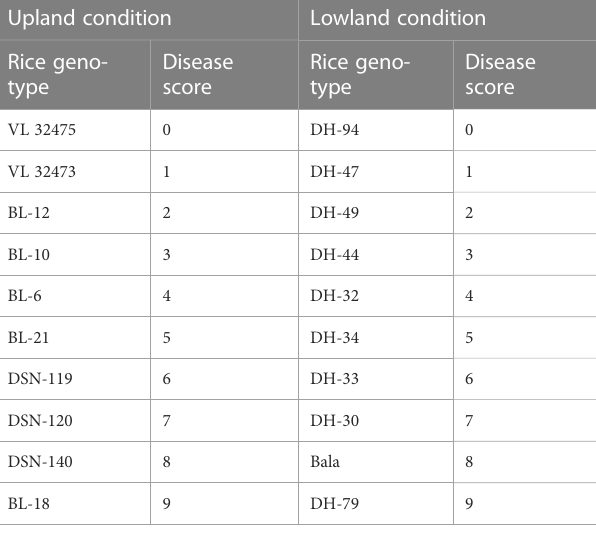
TABLE 4 Name of different genotypes of rice for both upland and lowland conditions. Upland